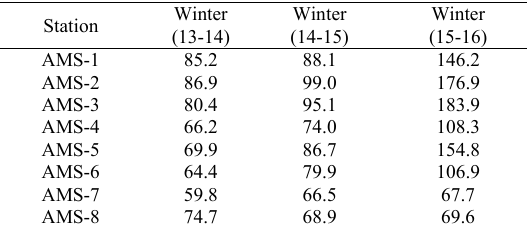
Table 7: AQI of different station bases on winter season